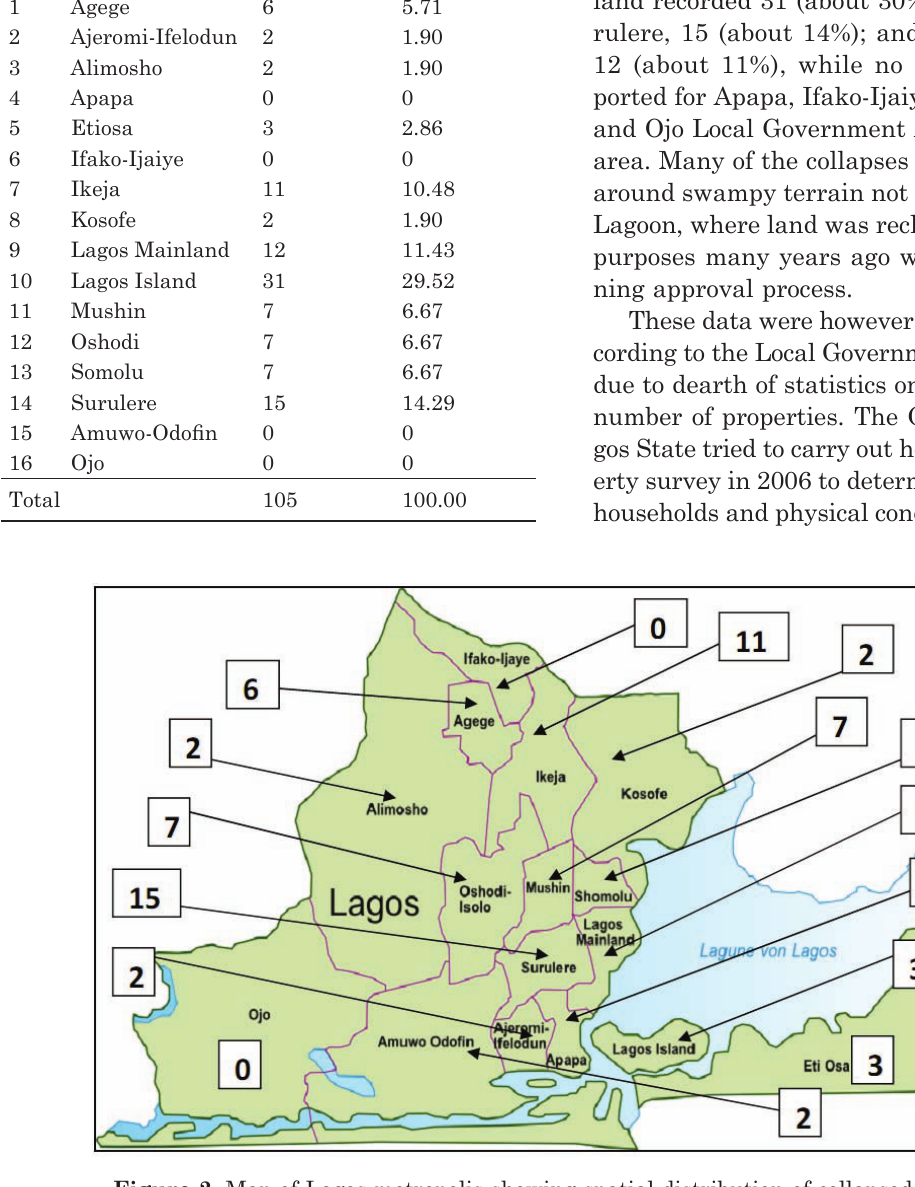
figure 2. Map of lagos metropolis showing spatial distribution of collapsed